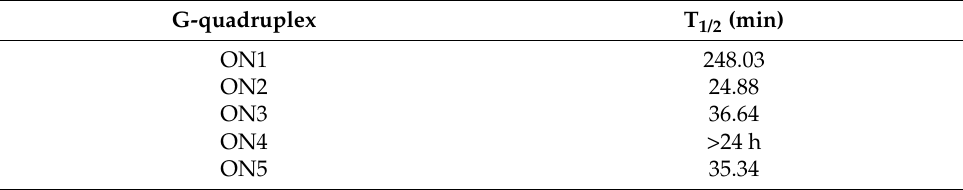
Table 2. Half-life of the